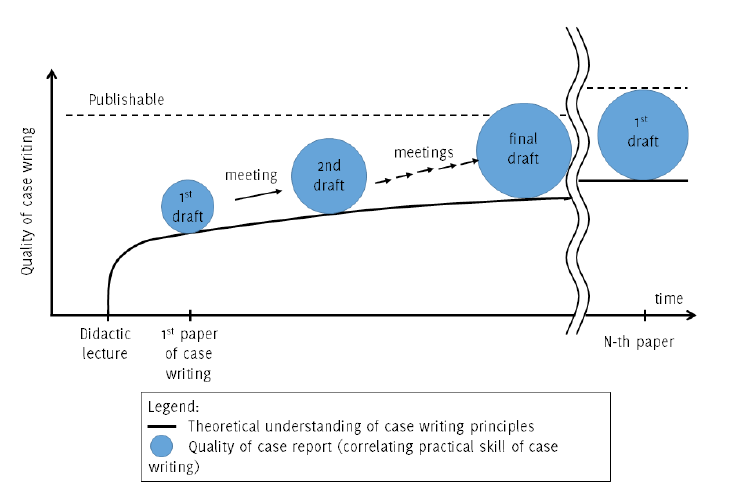
Figure 2. Feedback in the Process of Improving